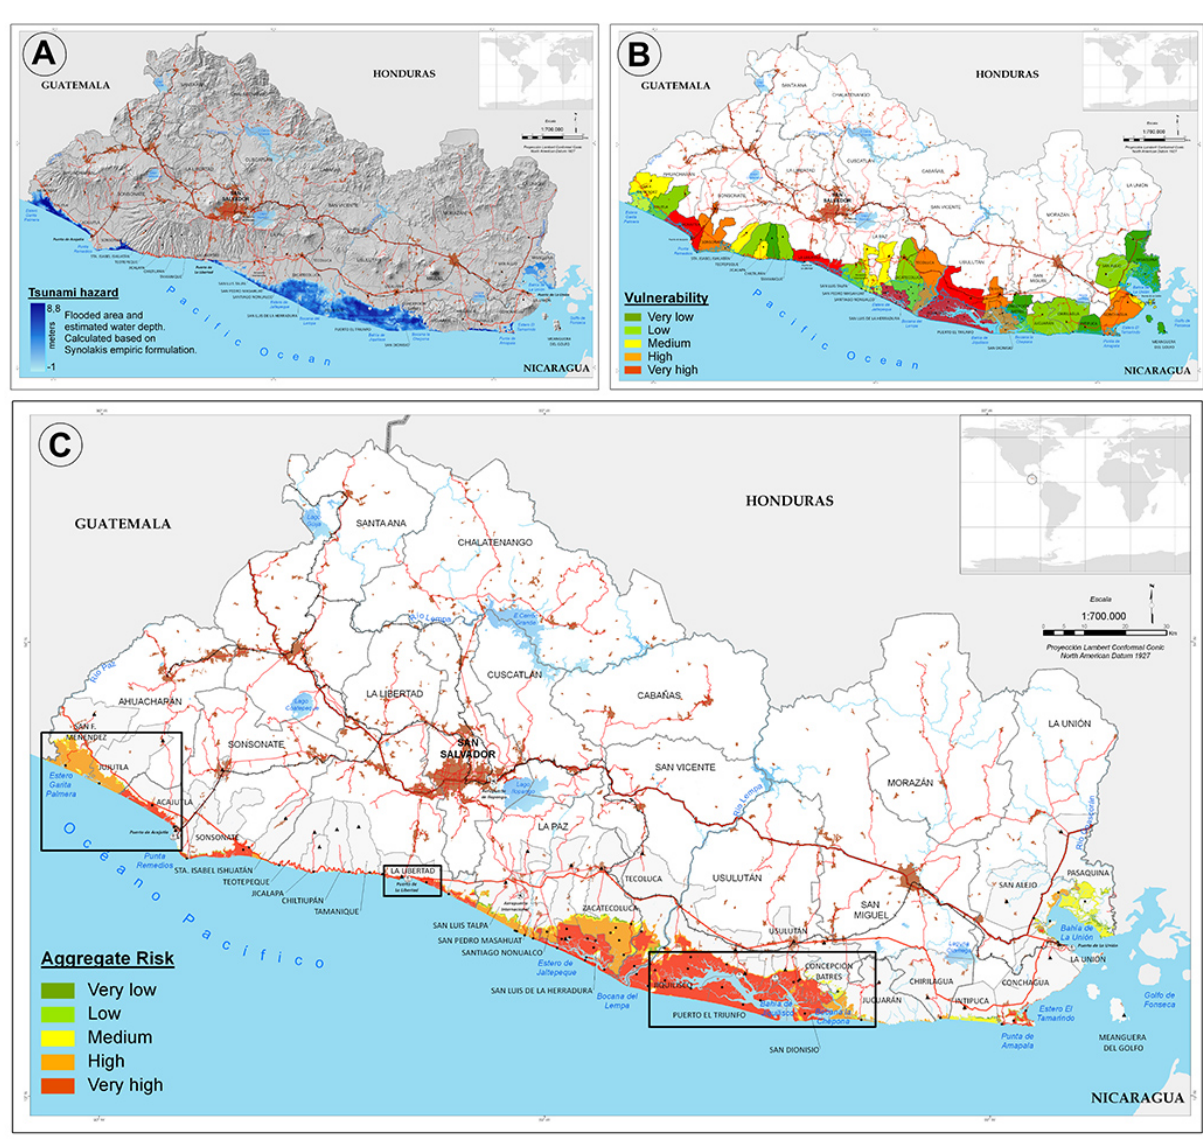
Figure 5. National tsunami risk assessment in El Salvador: (a) hazard assessment: flooded area and water depth results; (b) vulnerability as- sessment by municipality including the human, environmental, socioeconomic and infrastructural dimensions; (c) risk assessment combining hazard and vulnerability results via the risk matrix (the areas framed by black squares show the local studies carried out; from left to right: Western Coastal Plain, La Libertad municipality and Jiquilisco